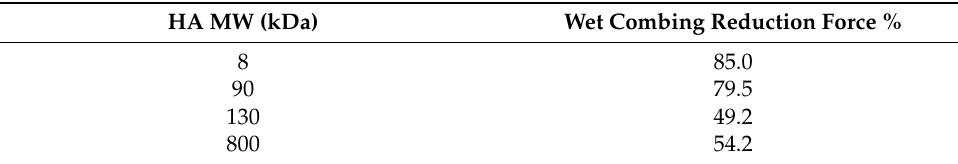
Table 1. Effect of HA Molecular Weight on Wet Combing Reduction Force.